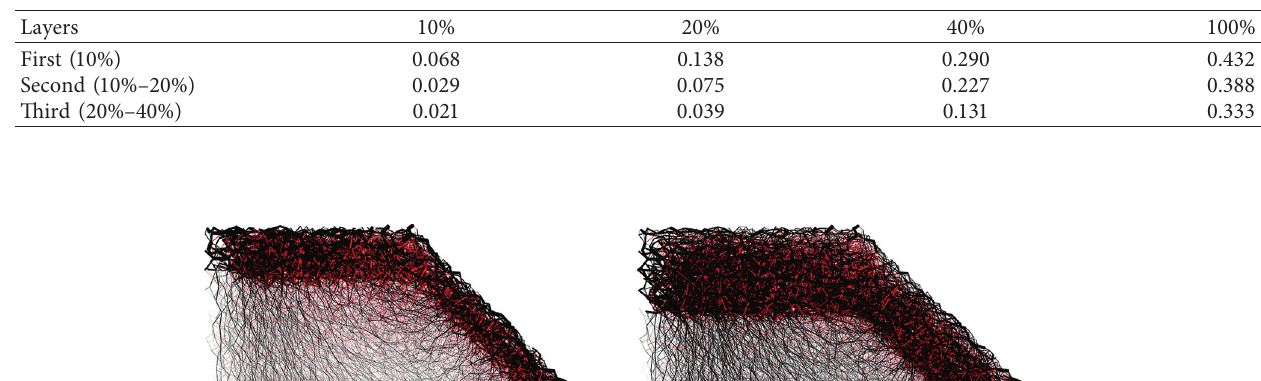
Table 4: The average displacement along the slope surface in each layer (unit: mm).